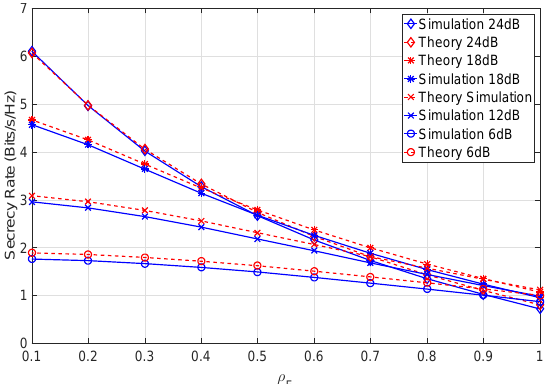
Figure 8. Secrecy rate of the system for different levels of SNR and with β N = 100 and β M =